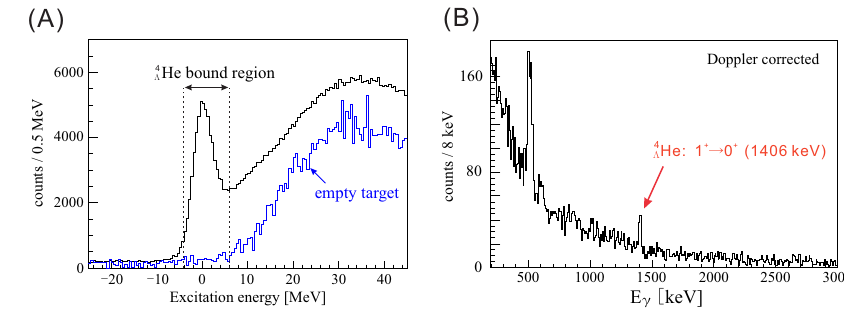
Figure 1. Result of the J-PARC E13 experiment for 4 (cid:3) He (cid:13) -ray spectroscopy [2]. (A) Missing mass spectrum measured in the 4 He( K (cid:0) ;(cid:25) (cid:0) ) reaction. (B) (cid:13) -ray spectrum with event-by-event Doppler shift correction after gating the peak region in the mass spectrum.